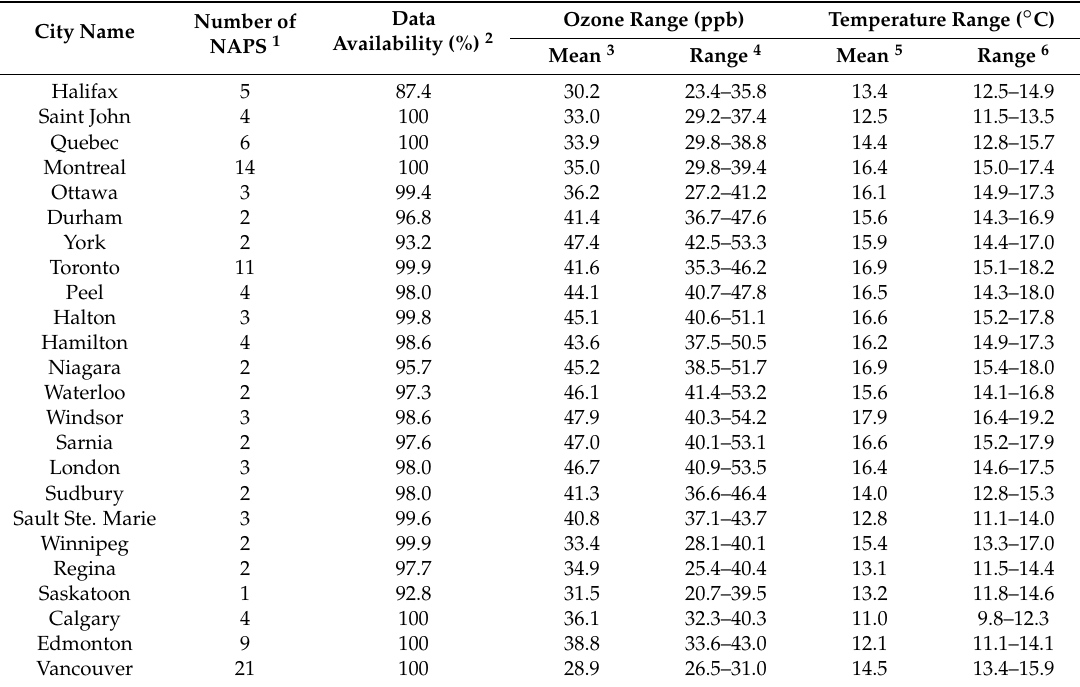
Table 3. Statistics for ozone and